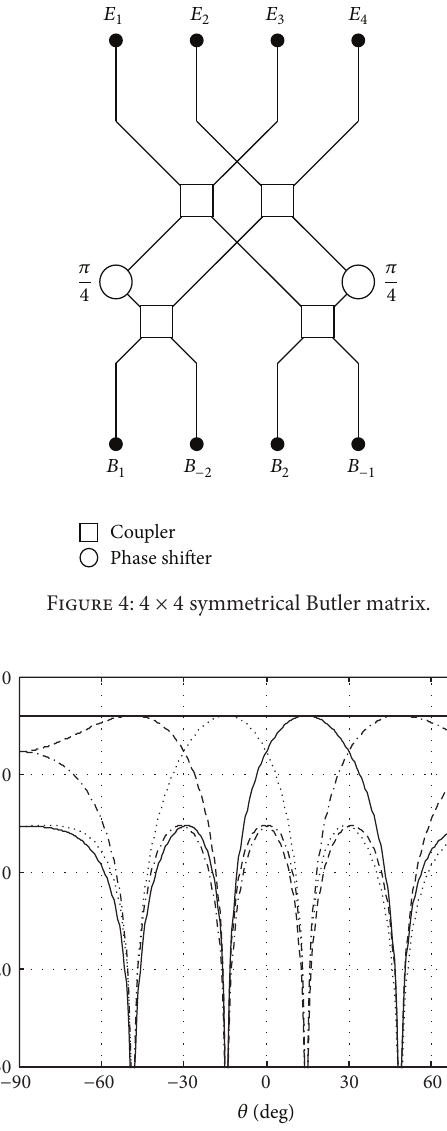
Figure 5 for 𝑑 𝜆 = 0.5 . The peak of the transfer function in the transmitting mode is 6 dB. As highlighted in Figure 5, the sum of the 4 patterns in any angular direction is constant and equal to the maximum of each beam pattern (6 dB) with contributions from the 4 beam ports varying depending on the observation angle. In the receiving mode, a similar phenomenon appears in the beam forming network. As the plane wave incidence angle varies, the power captured by the array elements is distributed among the beam ports. The power transmitted to a given beam port in the receiving mode as a function of the incidence angle varies as the corresponding beam pattern produced by this same